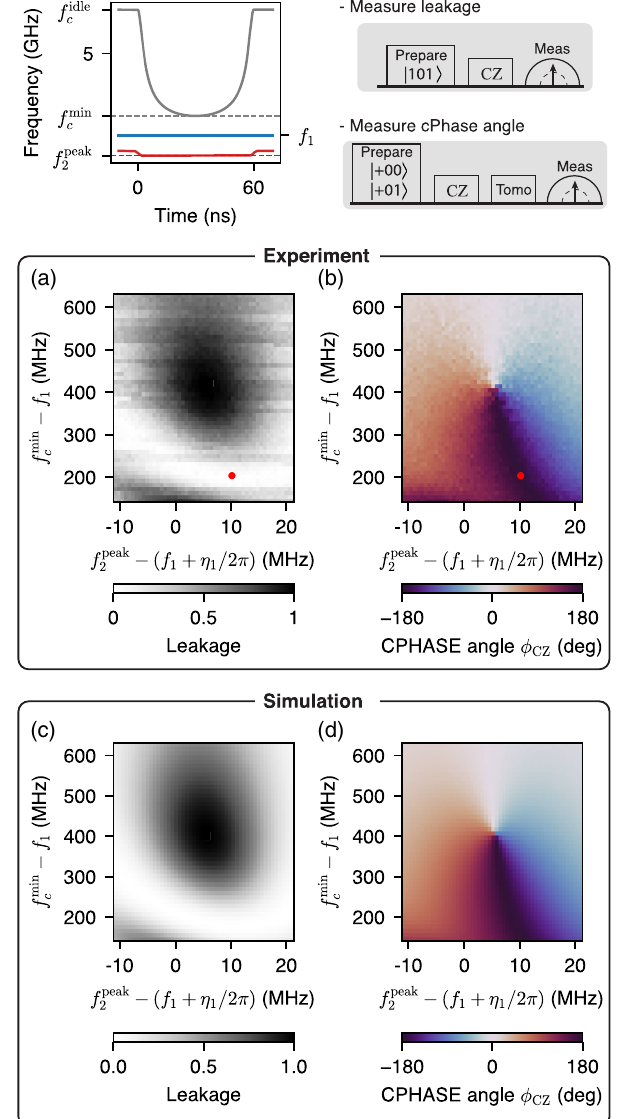
FIG. 29. Tune-up measurements for the CZ gate. (a),(b) Experimental data of tune-up measurements for a 60-ns-long CZ gate. We measure leakage from j 101 i and conditional phase (CPHASE) angle ϕ as functions of QB2 Z -pulse amplitude CZ ( x axis) and CPLR Z -pulse amplitude ( y axis). The control pulse and sequences to measure leakage and CPHASE angle are illustrated at the top. We find an optimal parameter set that minimizes both the leakage and CPHASE angle error (red circles). (c),(d) Numeric simulation reproducing the experimental data of tune-up measurements.